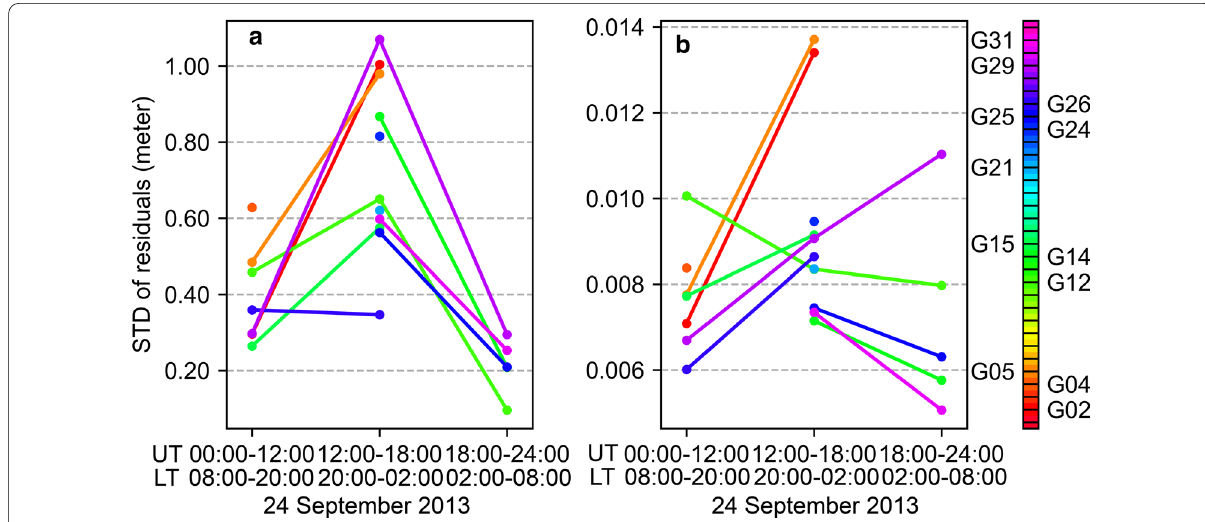
Fig. 14 STD of residuals on ionosphere-free pseudorange ( a ) and carrier phase ( b ) measurements for the satellites which suffer cycle slips from aspects of three period (1) 00:00–12:00 UT; (2) 12:00–18:00 UT; (3) 18:00–24:00 UT at the site of HKPC on 24 September 2013. The isolated points without linkage with other points mean that the satellites are just visible in one of the three